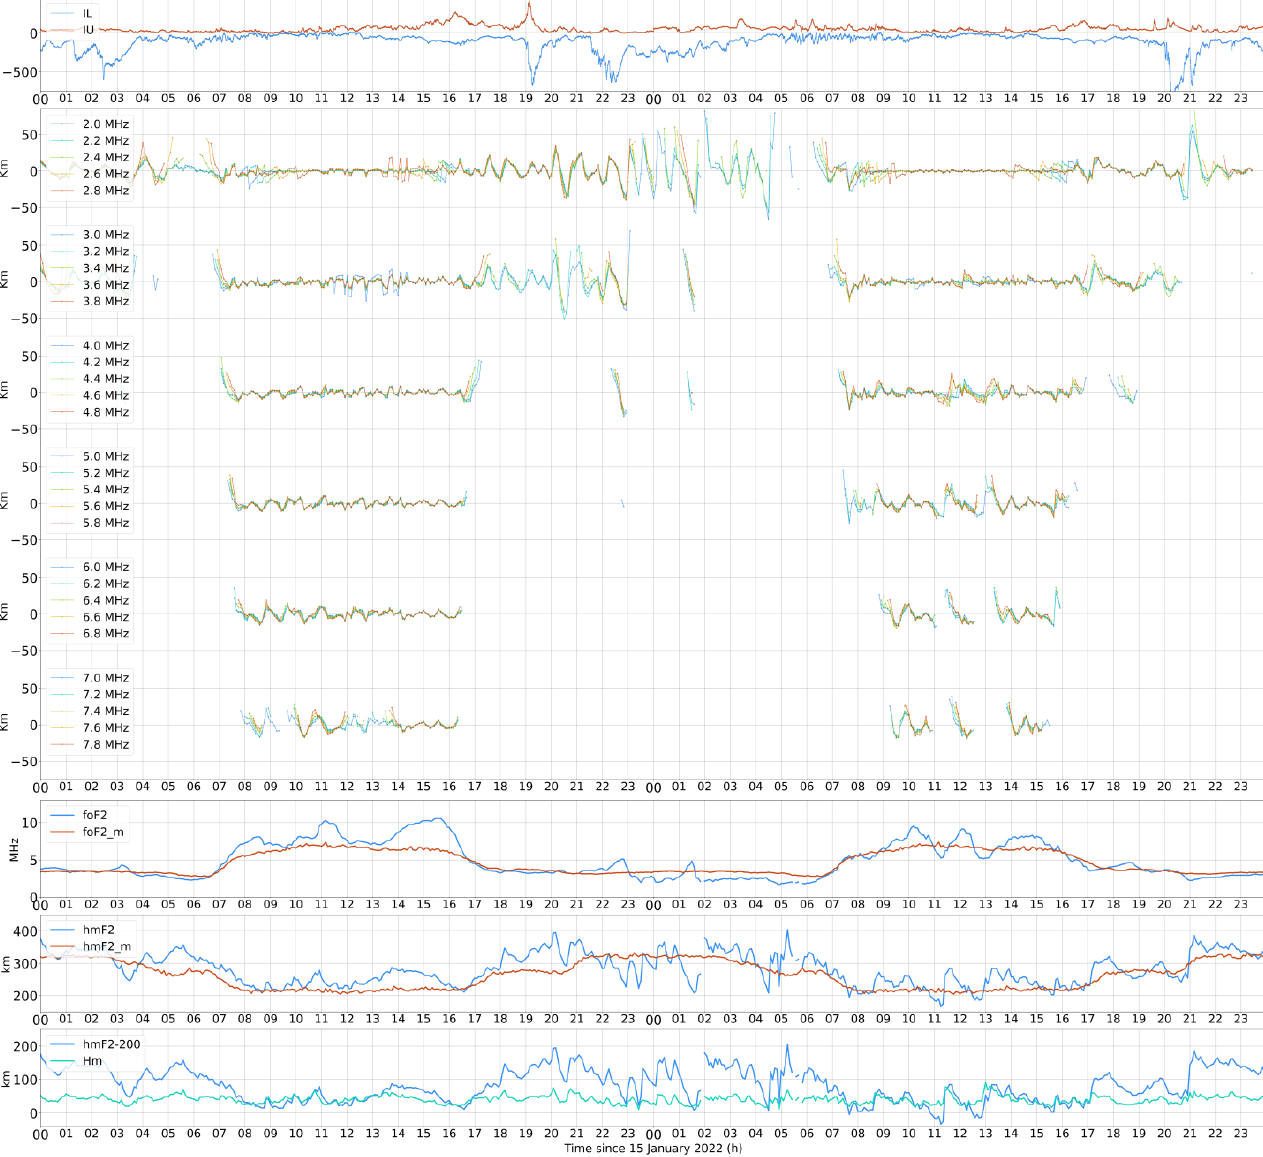
Figure 11. The same as Figure 9, for the Ebre location.